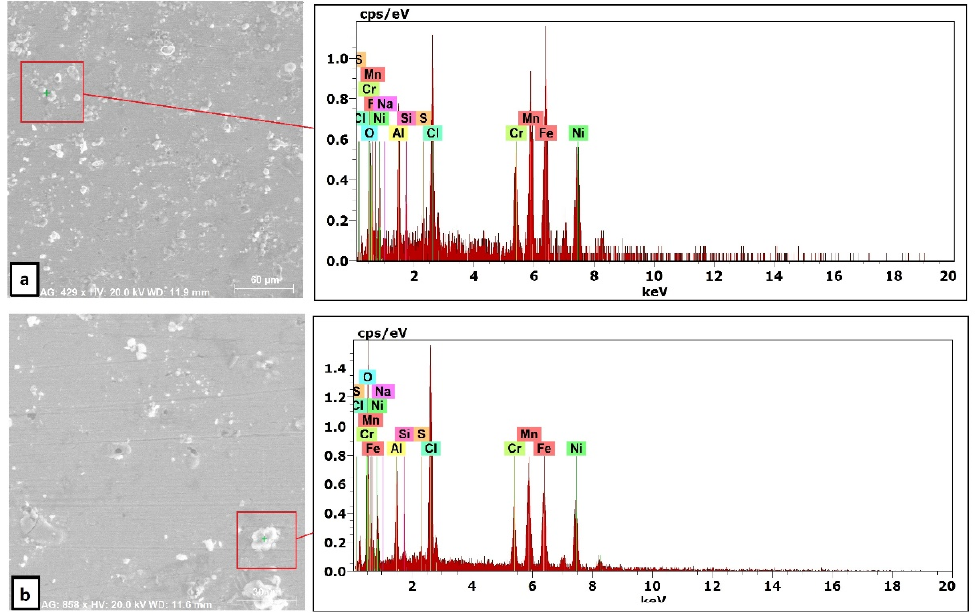
Figure 17. EDX patterns of the corroded HEA in cold-rolled and solution-treated condition in 0.6 M NaCl + 1 M H 2 SO 4 solution, where ( a ) SEM image of one of small pits, and ( b ) SEM image of one of large pits.